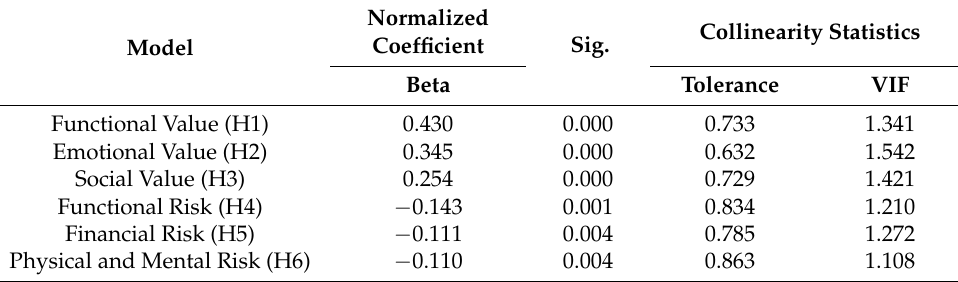
Table 8. Regression of perceived values of electric vehicle customers.